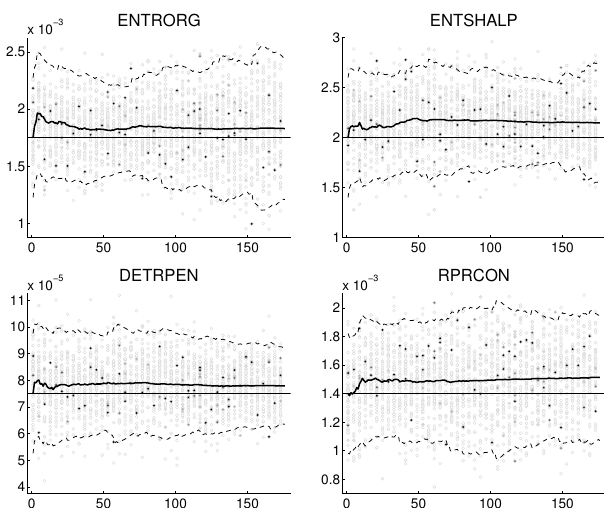
Fig. 1. Time evolution of the parameter values in 177 consecutive ensembles. A vertical column of markers represents parameter val- ues of one ensemble. The darker colors correspond to values with high likelihood. The parameter distribution mean value µ (thick line) and µ ± 2 × standard deviation (dashed lines) are also shown. For clarity, the default parameter value (thin horizontal line), and every fourth ensemble only is